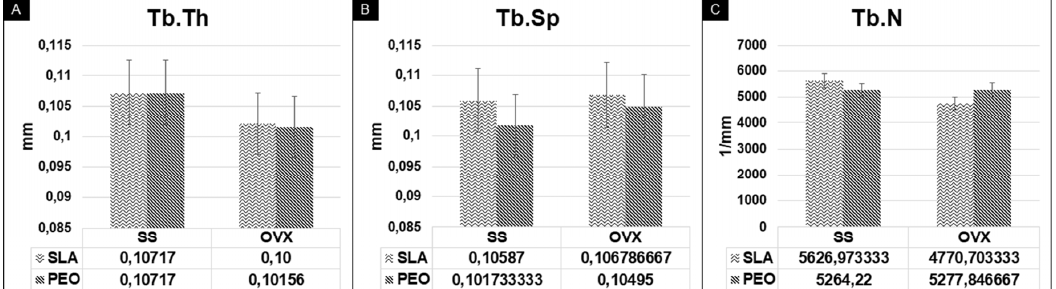
Figure 5. Microtomography parameters for bone quality: bone trabecular thickness (Tb.Th) ( A ), separation of bone trabeculae (Tb.Sp) ( B ), and number of trabeculae (Tb.N) ( C ) for SLA and PEO surface coating in groups SS and OVX at 60 days. There was statistical similarity among experimental groups.